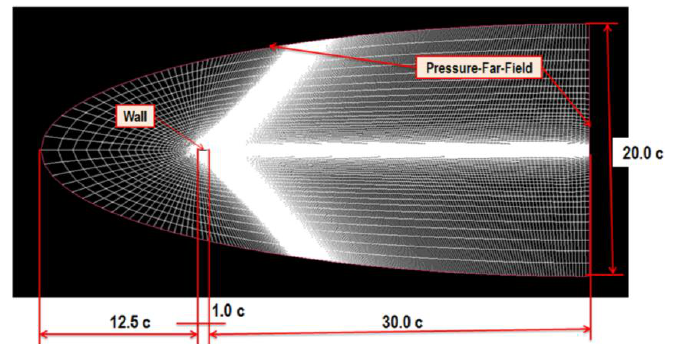
Figure 2. Domain of calculations and boundary conditions.